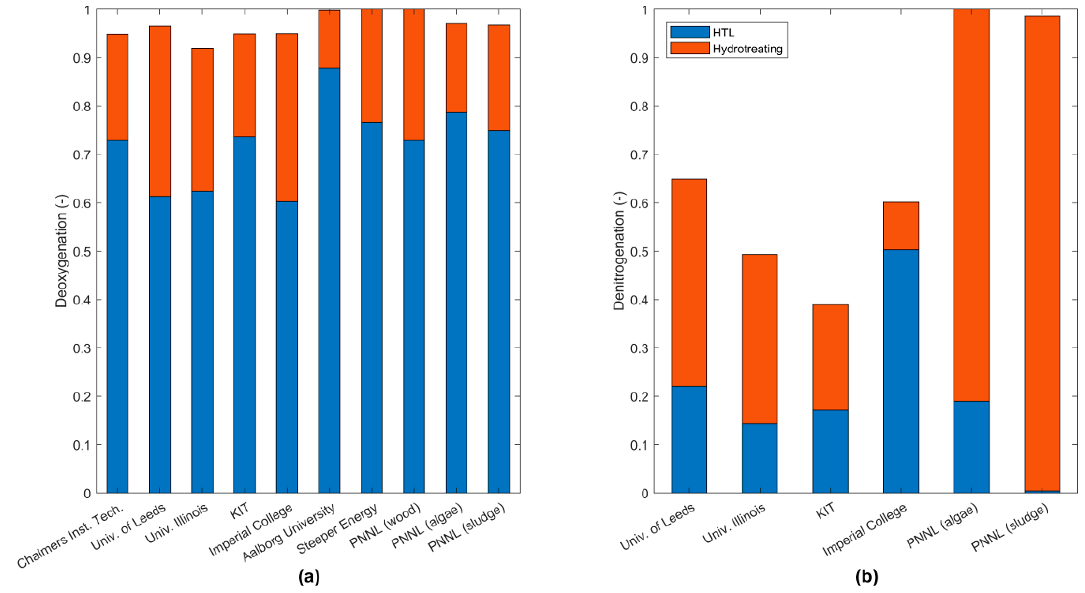
Figure 10. Extent of deoxygenation ( a ) and denitrogenation ( b ) achieved in the HTL and following hydrotreating of the biocrude. Information on feedstock and catalyst can be found in Table 2.